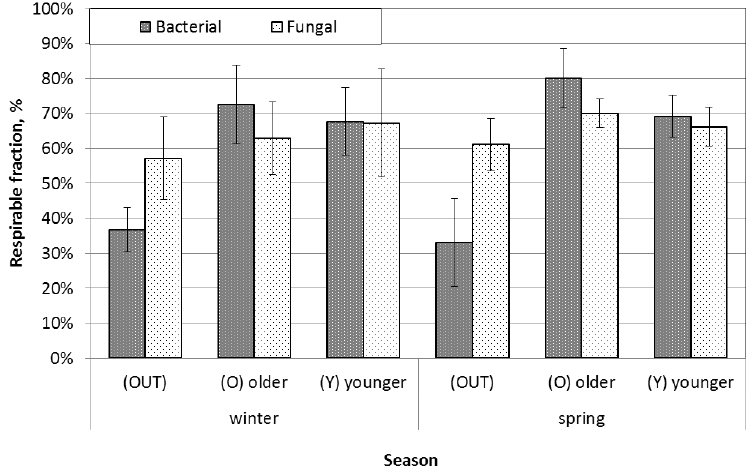
Figure 3. Respirable fraction of bacterial and fungal aerosols.